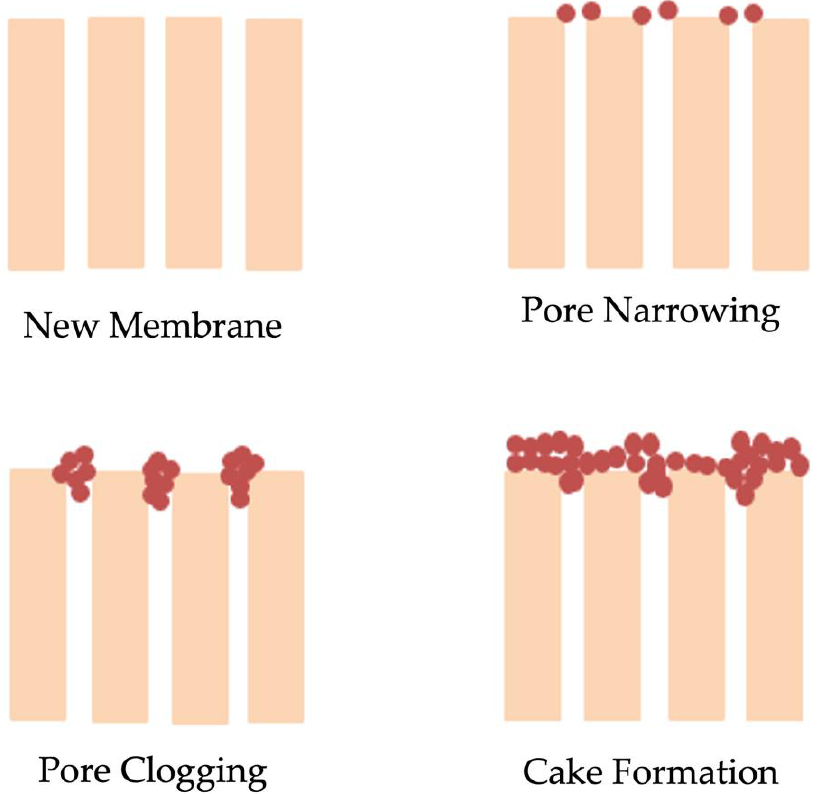
Figure 2. The scheme of the mechanisms of membrane fouling.